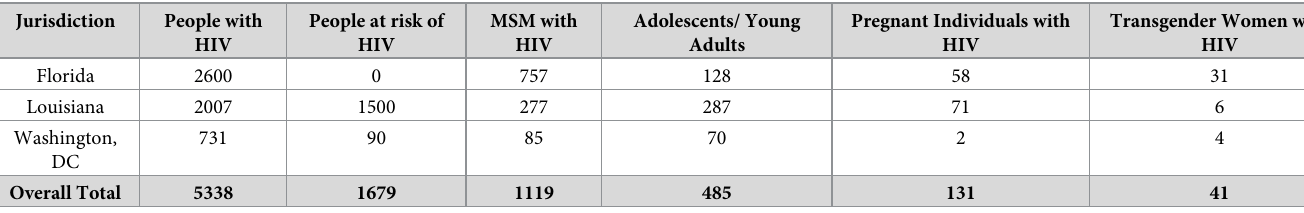
Table 1. Pre-intervention data survey